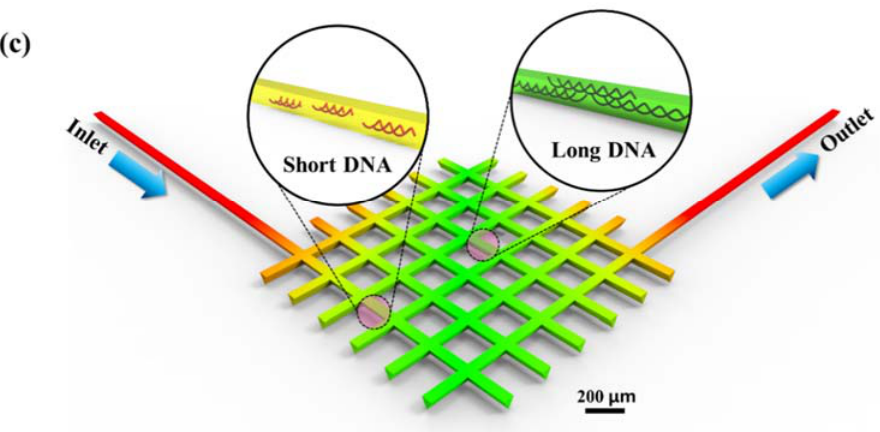
Figure 1. Schematics of the femtosecond laser micro-scribing system and a microfluidic DNA distributor. Image ( a ) shows an overall view of the femtosecond laser system; Image ( b ) shows the jig used for polymer sample fixation; and ( c ) shows a schematic of the microfluidic DNA distributor (channel spacing 200 μ m × 200 μ m).